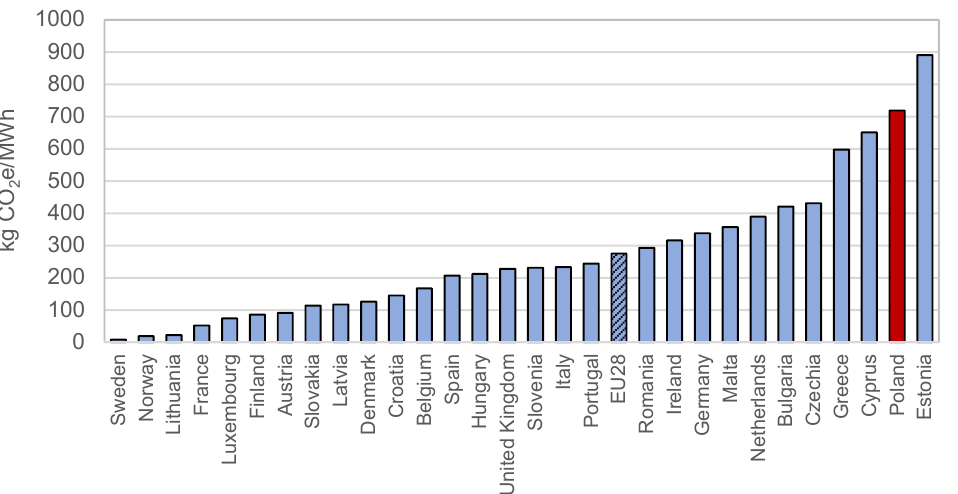
Figure 2. Greenhouse gas emission intensity of electricity generation (as a CO 2 equivalent) in EU countries in 2019. Source: own elaboration based on [29].